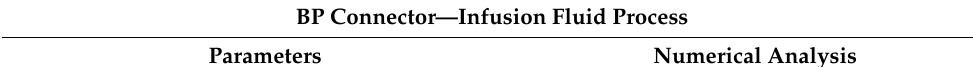
Table 3. Flow, pressure, and vorticity numerical analysis for BP connector—infusion fluid process.